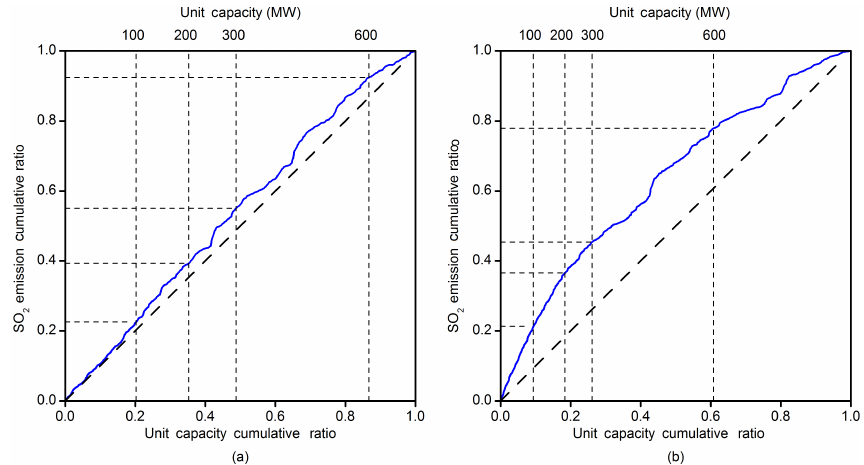
Figure 7. Cumulative ratio of SO 2 emissions by unit capacity for the years (a) 2005 and (b) 2010. The units are sorted according to ascending capacity along the x axis.